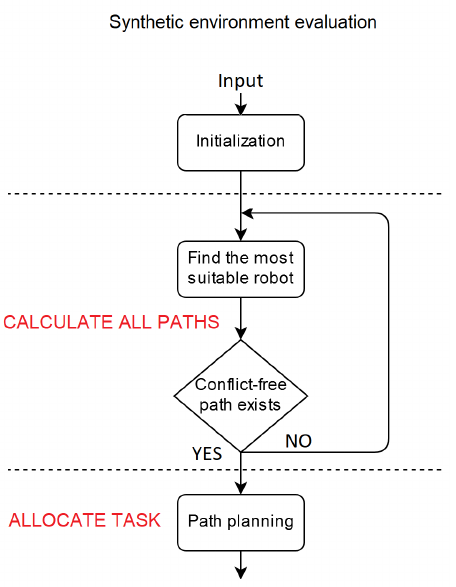
Figure 1. The stages of the proposed